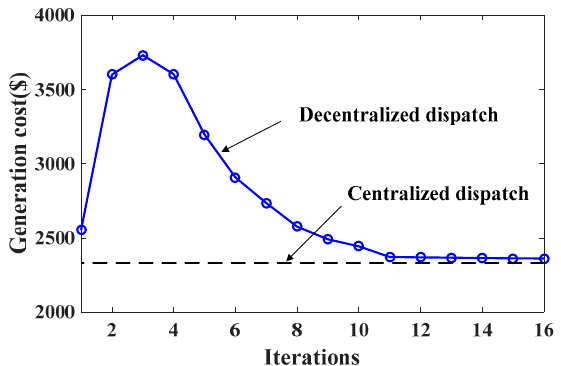
Figure 7. Iteration curve of active power of ADN and VPPs ( a ) 3rd period; ( b ) 9th period; ( c ) 15th period; ( d ) 20th period.